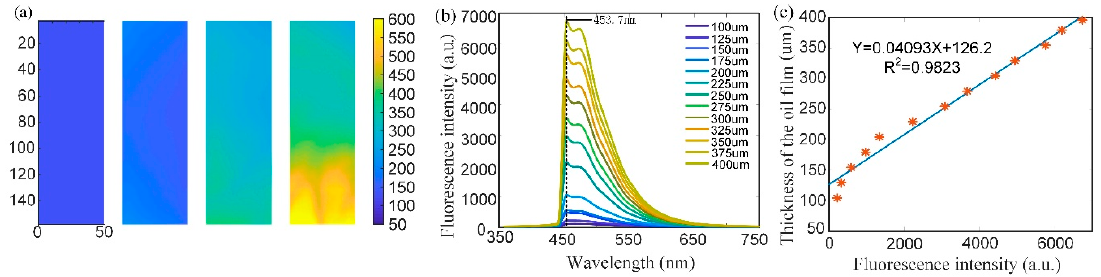
Figure 6. The relation of the thickness of the diesel film and its fluorescence intensity. ( a ) The distributions of the thicknesses of oil with average thicknesses of 100 μ m, 200 μ m, 300 μ m, and 400 μ m; ( b ) The spectra of the different thicknesses of the oil film. ( c ) The fitting curve of the thickness of the oil film and fluorescence intensity of the peaks of the spectra.